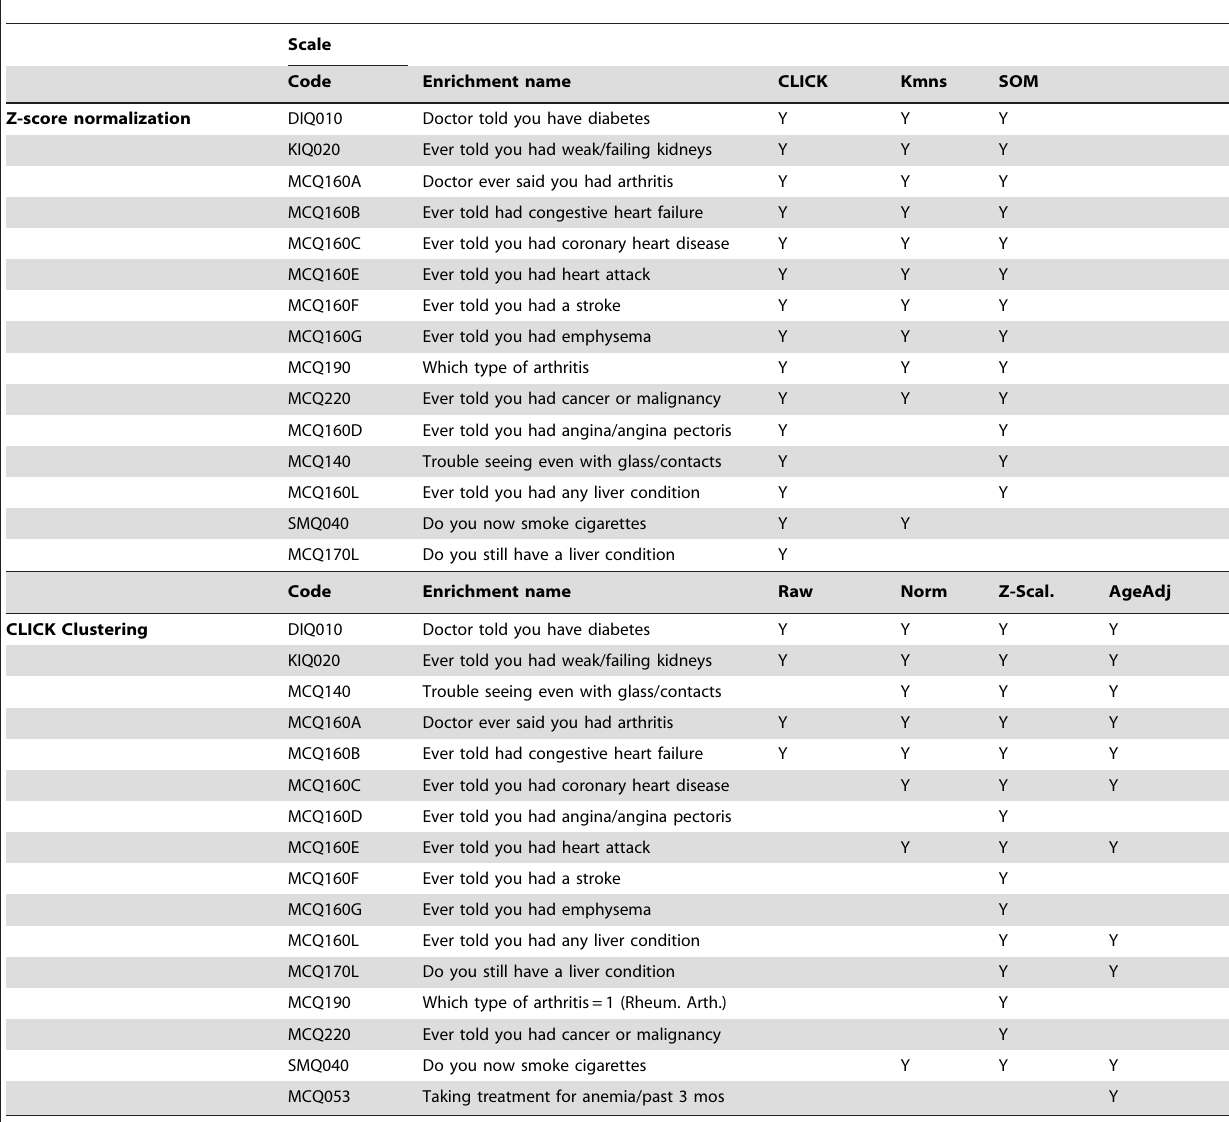
Table 3. Enrichment analysis of biomarker-based patient clusters: A qualitative